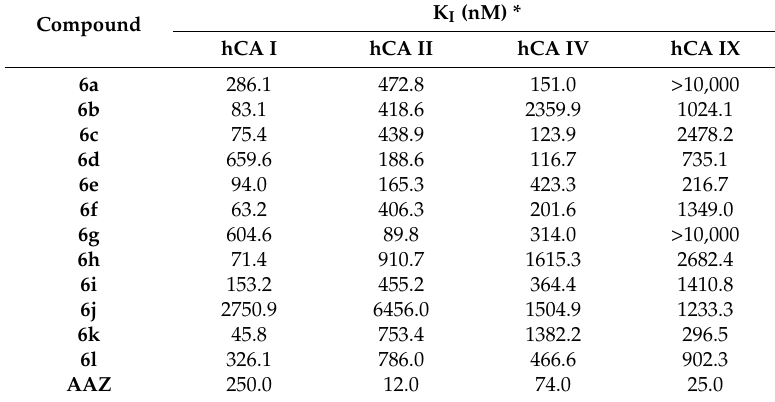
Table 1. Inhibition data of hCA I, hCA II, hCA IV, hCA IX with compounds 6a – l and the standard